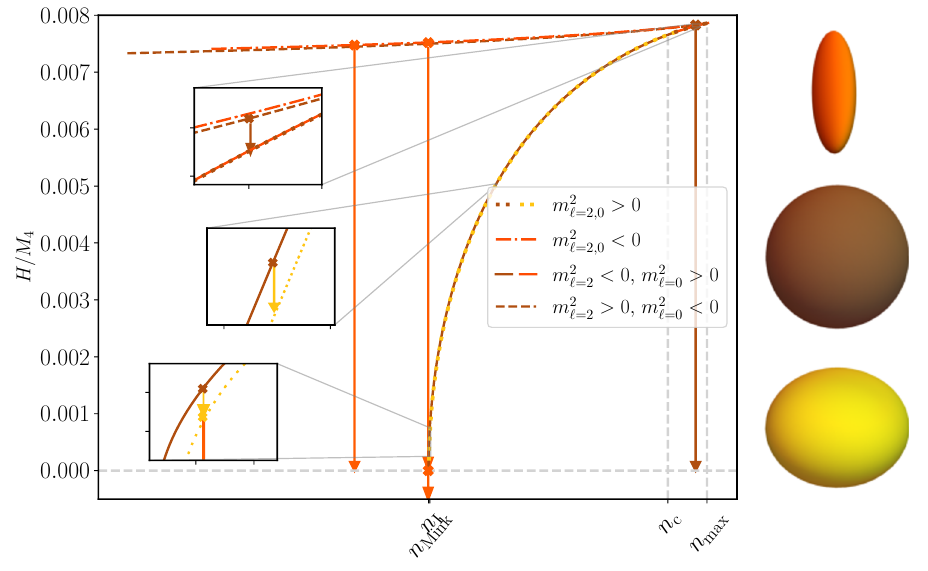
Figure 1 . A cartoon of the Freund-Rubin and ellipsoidal solutions in the ( H/M 4 , n ) plane for Λ = 1 and q = 4 . For each value of the conserved flux number (2.8), there are two solutions: a D symmetric solution where the compact space is spherical with an aspect ratio (cid:15) = 1 (indicated in brown), and a warped solution where the internal manifold is oblate with (cid:15) < 1 (yellow) or prolate with (cid:15) > 1 (orange). We find three critical values of n . First, for n there are two Mink < n < n max Freund-Rubin and two warped solutions: on the Freund-Rubin branch there is a small and a large volume branch perturbatively stable or unstable to the volume instability ( m 2 > 0 or m 2 < 0 ) l =0 l =0 respectively. At n = n the two branches merge and annihilate. On the warped branch there is max one solution on the large Hubble warped branch, perturbatively unstable to the warped instability ( m 2 < 0 ) and a solution on the small Hubble warped branch. At n = n c the small Hubble warped l =2 branch intersects the small volume Freund-Rubin branch and the two branches are marginally stable to the warped instability ( m 2 = 0 ). Whenever the ellipsoidal solution has (cid:15) > 1 it is also l =2 perturbatively unstable. Arrows indicate the specific nonlinear solutions we discuss in section 4. They all point towards a solution with smaller effective Hubble rate and higher entropy